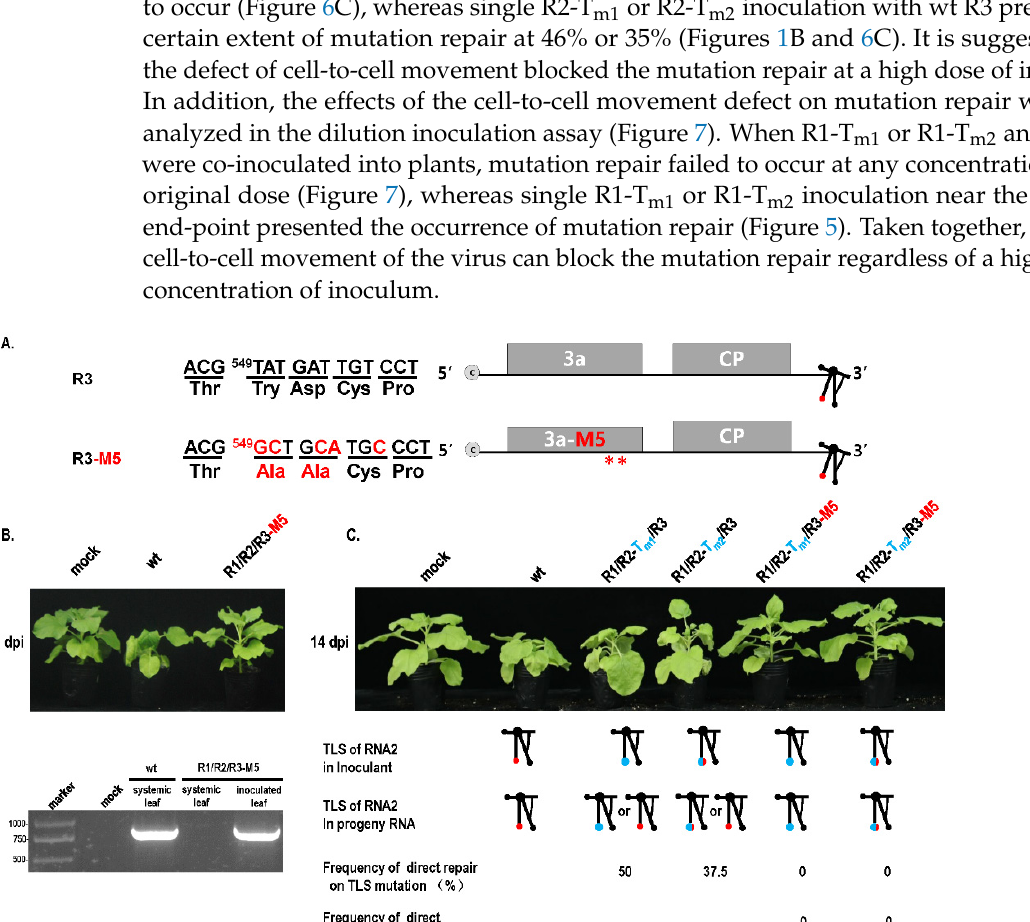
Figure 7. Effect of cell-to-cell movement on mutant repair in dilution inoculation assay. Mutation repair assay under dilution inoculation of ( A ) R1-T m1 /R2/R3-M5. R1—RNA1 of CMV Fny ; R2—RNA2 of CMV Fny ; R3-M5—3a mutation in RNA3 of CMV Fny . ( B ) R1-T m2 /R2/R3-M5. ( C ) Wild-type CMV.